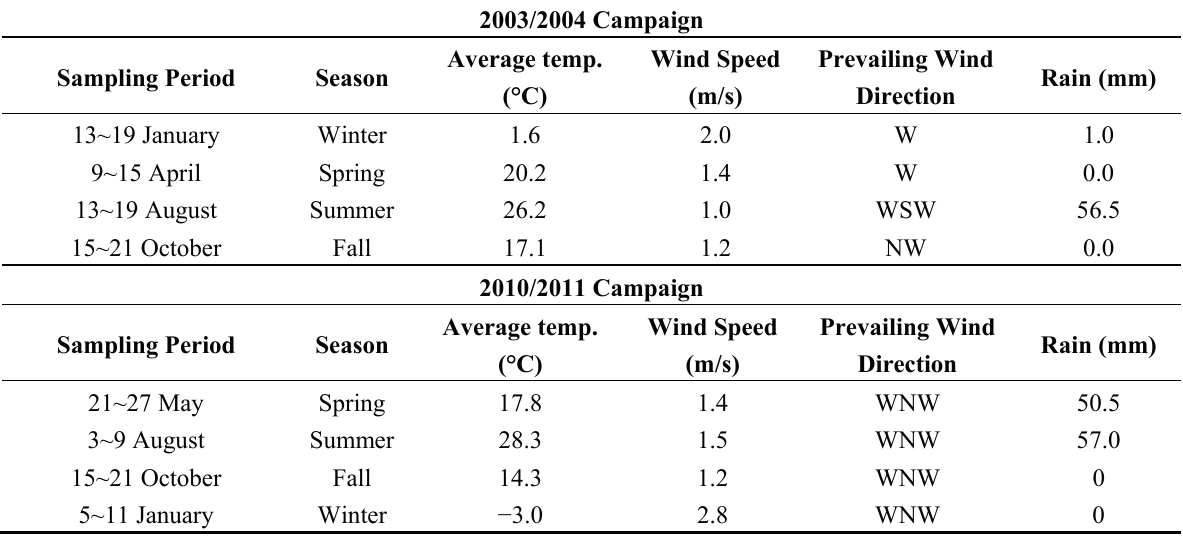
Figure 5. Seasonal variations of the selected VOCs at four different sites during 2010/2011 (the error bar indicates a standard deviation). I #1: industrial sit 1, I #2: industrial site #2, R: residential site, C: commercial site. Table 5. Meteorological conditions during the first and the second campaigns in Gumi